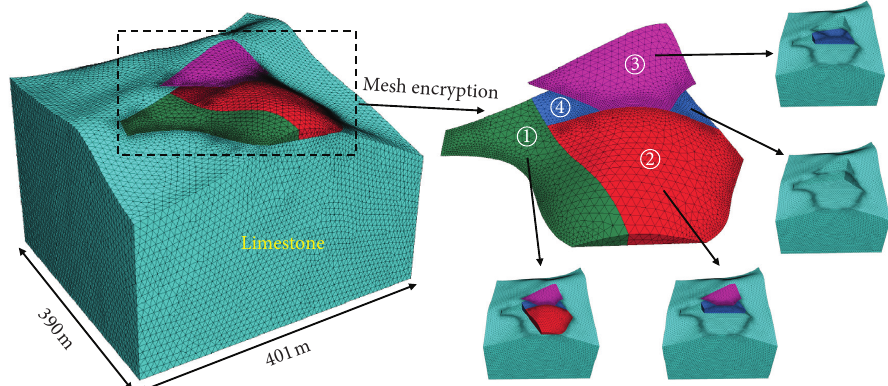
Figure 5: Model size and excavation sequence.